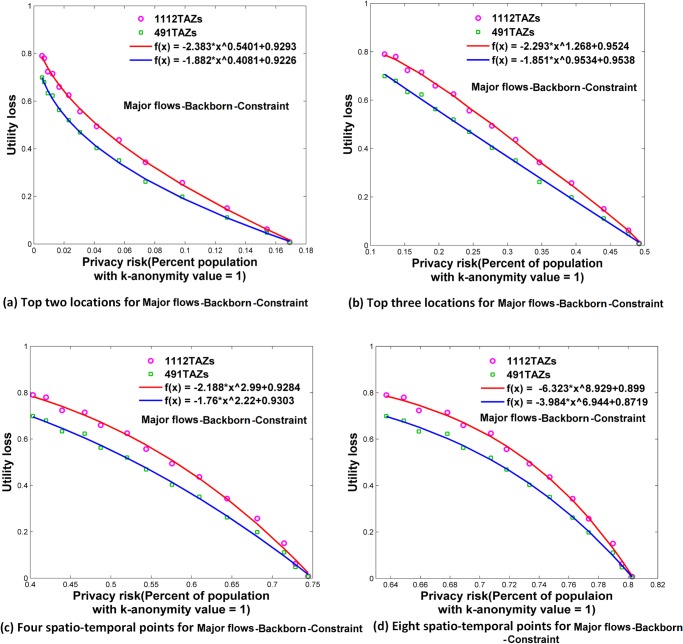
Relationships between privacy risk and data utility using Major flows-Backborn-Constraint.(a) Top two locations. (b) Top three locations. (c) Four spatio-temporal points. (d) Eight spatio-temporal points.